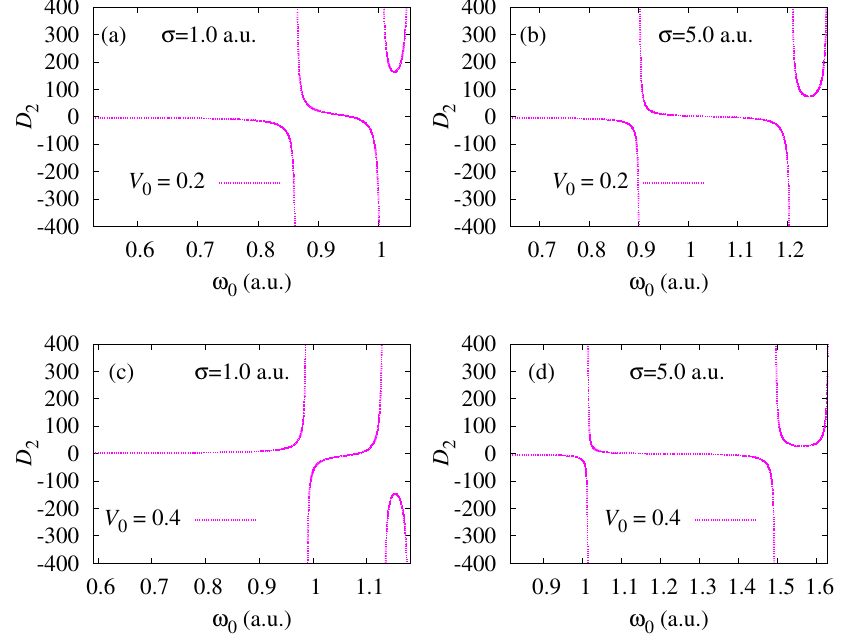
Figure 5. Variation of two-photon 1 s → 4 d transition probability amplitude with frequency of incoming photons, ω 0 , for ( a ) V 0 = 0.2a.u. and σ = 1.0 a.u.; ( b ) V 0 = 0.2 a.u. and σ = 5.0 a.u.; ( c ) V 0 = 0.4 a.u. and σ = 1.0 a.u.; ( d ) V 0 = 0.4 a.u. and σ = 5.0